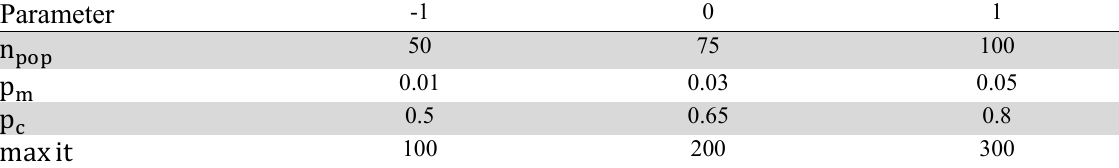
Coding parameters and levels tested for NSGAII